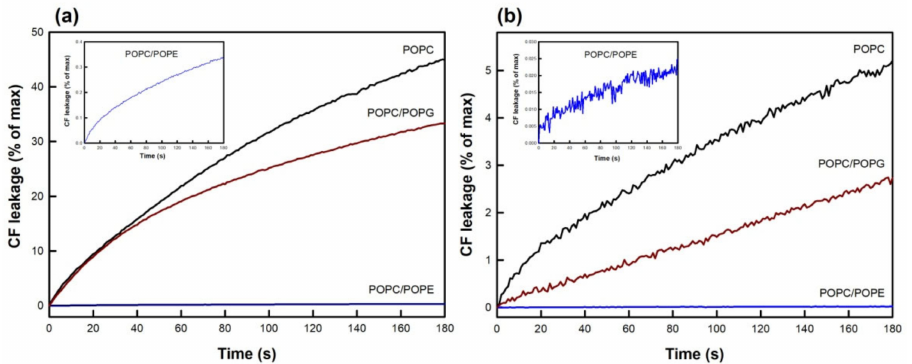
Figure 4. The effect of lipid composition on druginduced CF leakage. ( a ) TMX or ( b ) HTMX were added, at 17.5 µ M concentration, to LUV composed of POPC (black), POPC/POPG 5:1.7 (red), or POPC/POPE 5:1.7 (blue). The insets show a close-up view of the curves corresponding to the POPC/POPE composition. Total phospholipid concentration was 20 µ M (drug/phospholipid ratio 0.9), and temperature was thermostated to 25 ◦